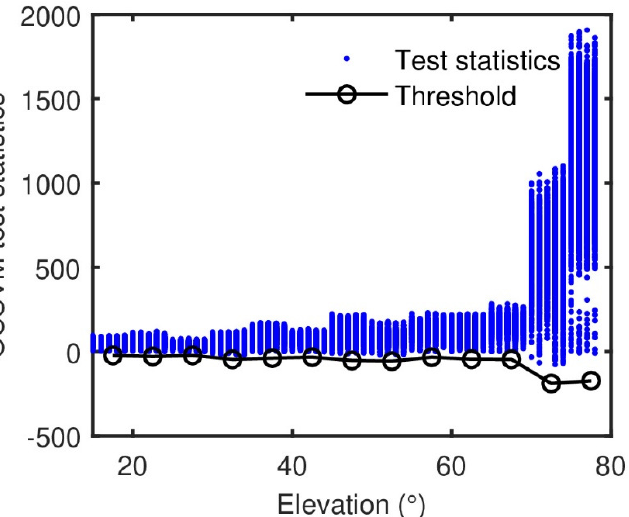
Figure 13. Variation of the metric and threshold of the proposed OCSVM-based monitor in terms of satellite elevations.